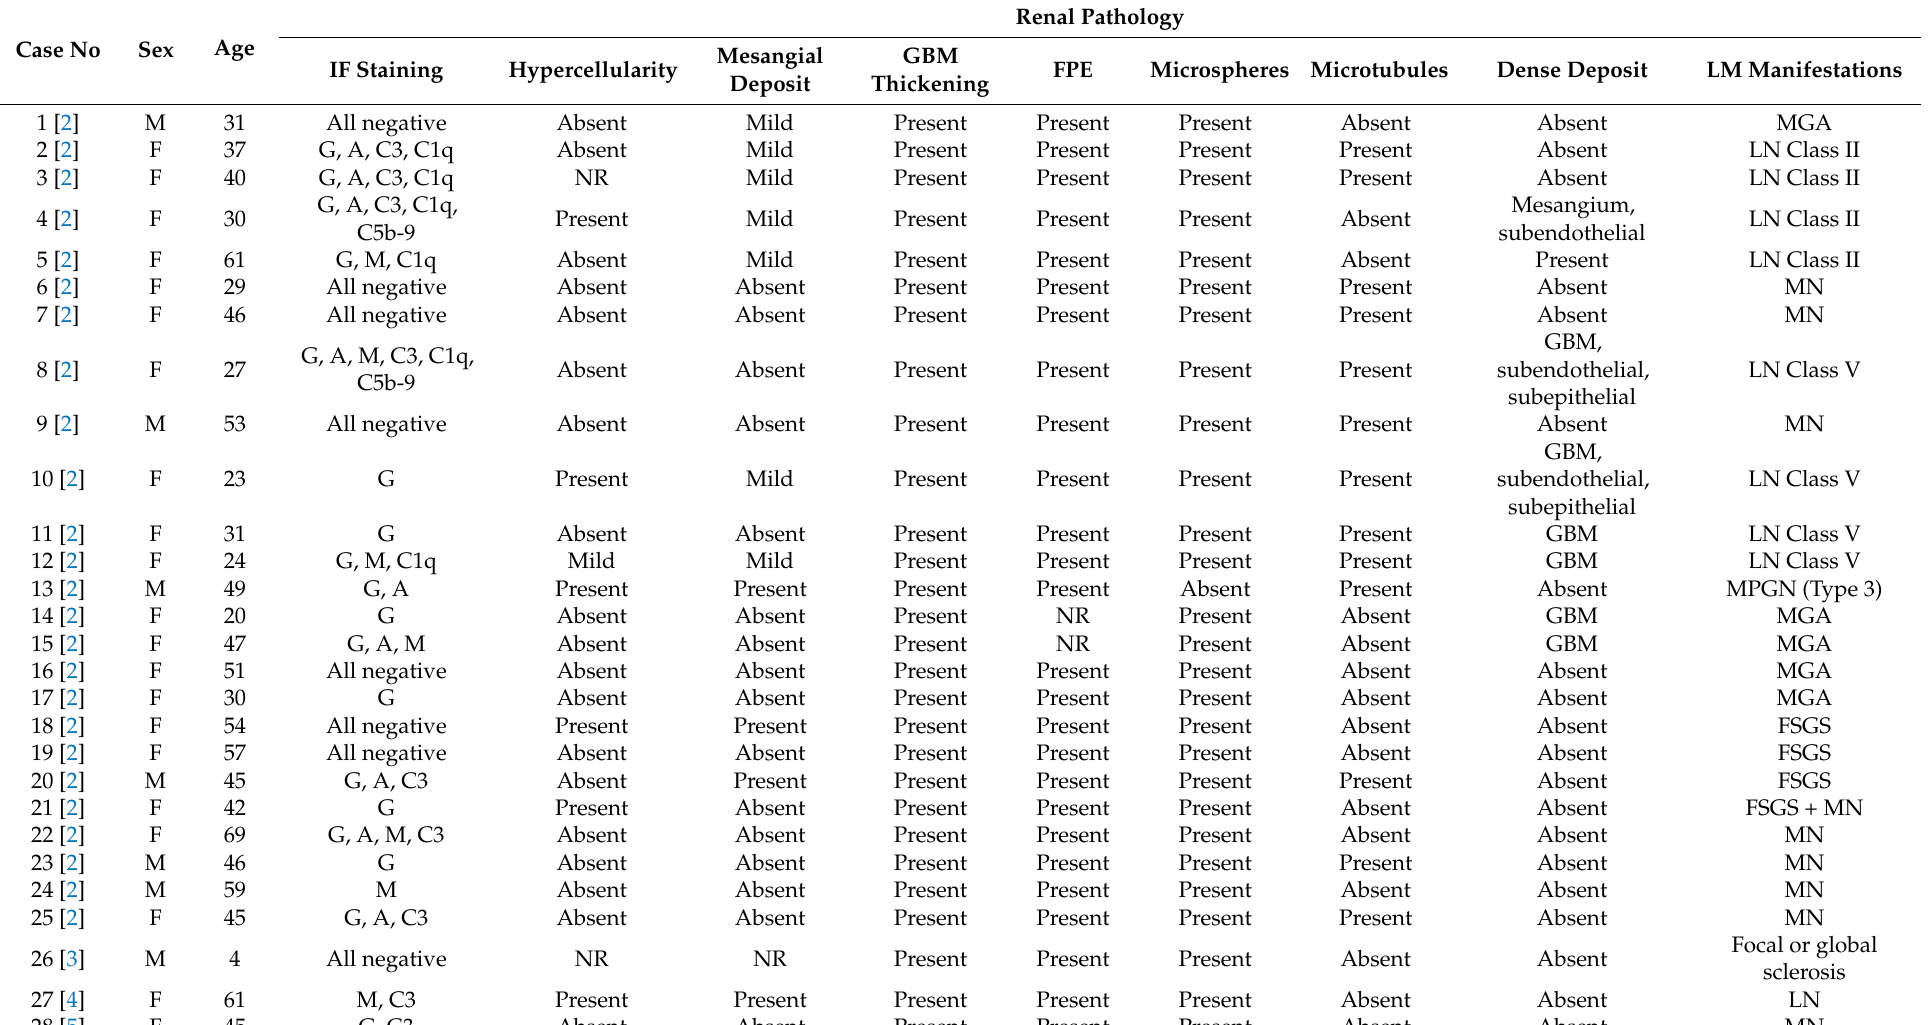
Table 2. Characteristics of pathological profiles of PIG cases reported in the literature and in this case